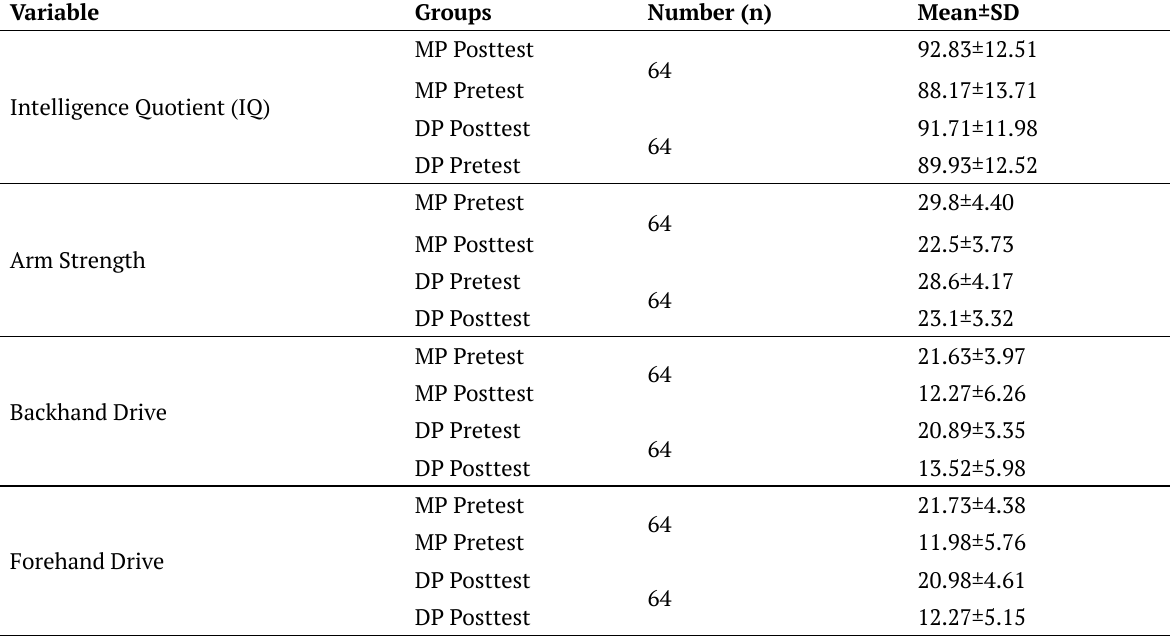
Table 2. Profile of Arm Strength, IQ, and Tennis